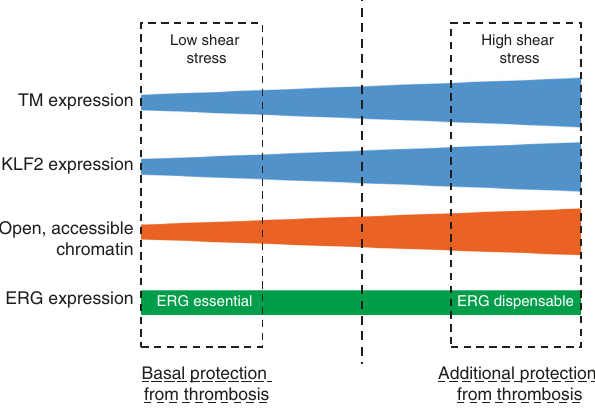
Fig. 9 Distinct anti-thrombotic pathways in low versus high shear stress conditions. Model of vascular bed-speci fi c anticoagulant pathway effective selectively in blood vessels exposed to low SS. Under low shear stress (SS), EC express relatively low levels of KLF2 and TM. ERG is essential for p300